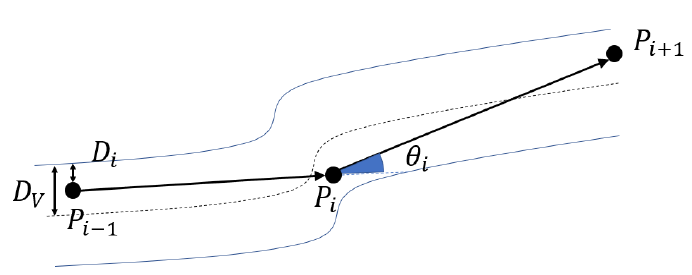
Figure 14. Safety ( ST ) metric.